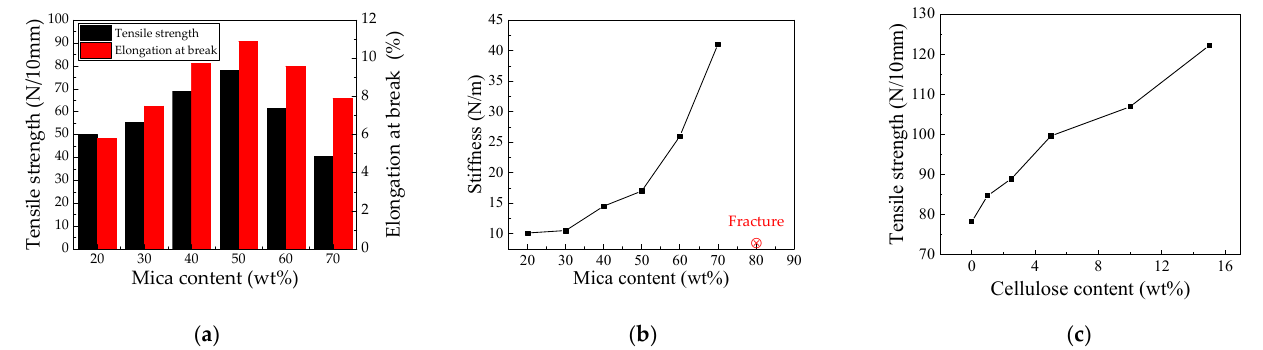
Figure 2. Mechanics properties of the mica composites ( a , b ) and mica/chitosan/nanocellulose com- posites ( c ). composites ( c